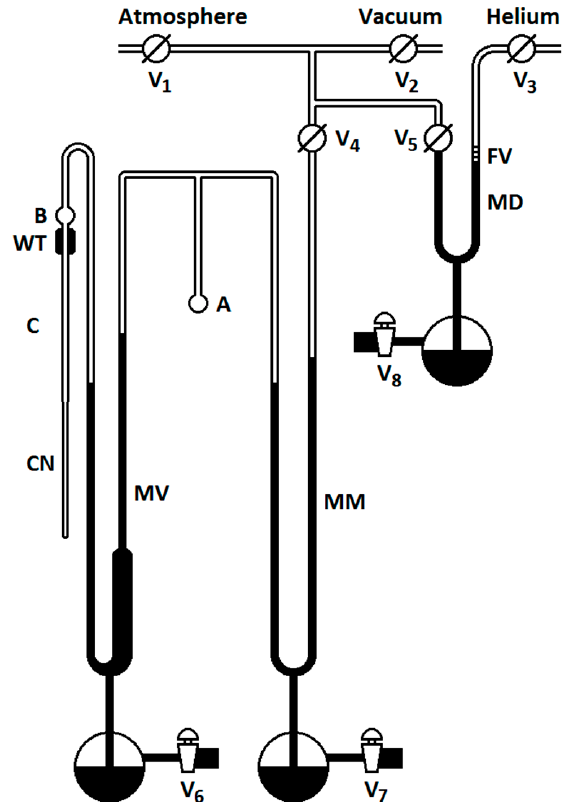
Figure 3. Schematic of sorption apparatus (C: measuring capillary, CN: narrower part of capillary tube, B: glass bubble, WT: cotton tampon damp in water, A: sample ampoule, MM: mercury manometer